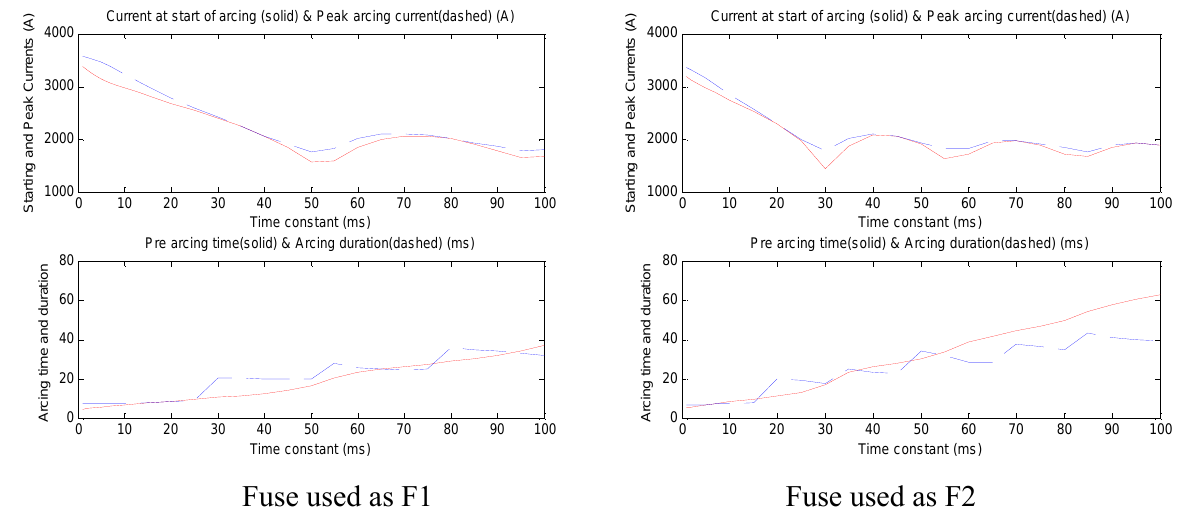
Figure 6. Variation of the current at start of arcing (A), peak arcing current (A), pre-arcing time (ms) and arcing duration (ms) versus the DC machine time constant (ms) when the 200 A fuse used as F1 and F2.